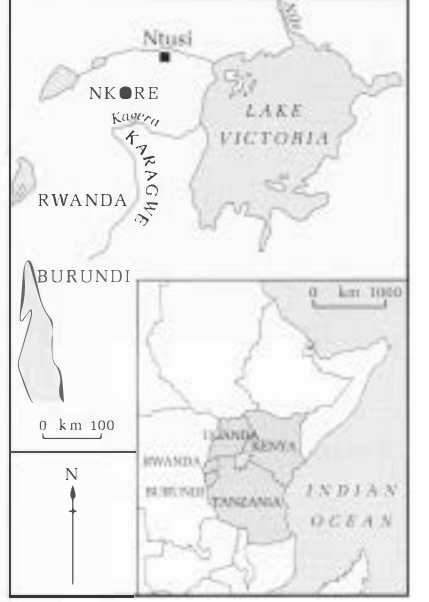
Figure 4 Pre-colonial kingdoms associ­ ated with cattle in the Great Lakes region. governance and protection of the kingdom.